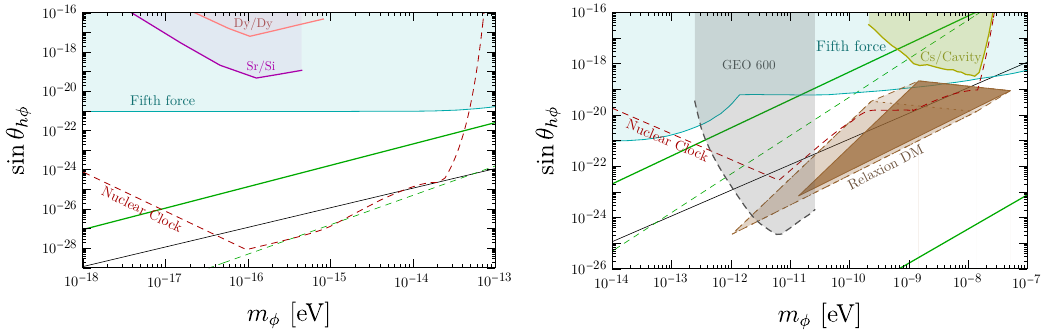
Figure 6 . A relaxion window and updated parameter space for the light relaxion in the presence of a solar halo (left), and an earth halo (right). In the presence of such halos, the sensitivity of the various clock tests described in (cid:12)gure 5 enhances because of the density and longer coherence time of those objects as described in [73, 77]. (Right) The yellow shaded region describes the sensitivity reach of Cesium clock-cavity comparison test [74] in the presence of an earth